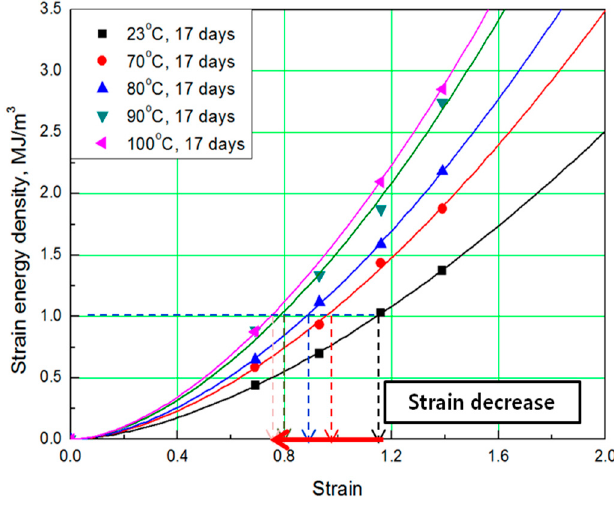
Figure 4. SED-strain curves according to aging temperature. Table 2. Coefficients of SED strain curves.